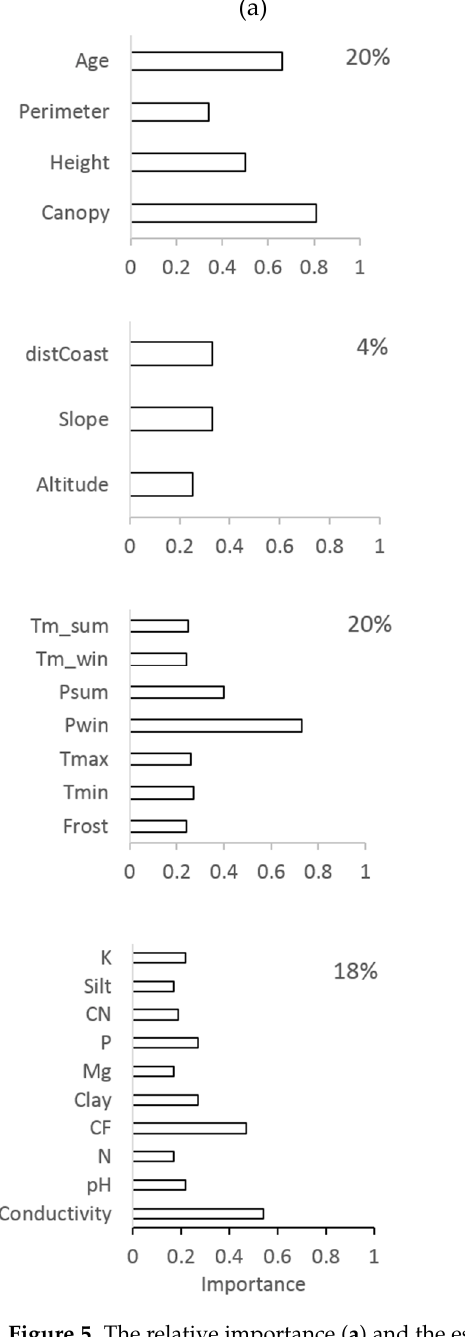
Figure 5. The relative importance ( a ) and the estimated coefficients ( b ) of variables estimated across all fitted GLM models using a multi-model average approach for the Dieback symptom. We also indicate the percentage of deviance explained by each complete model.